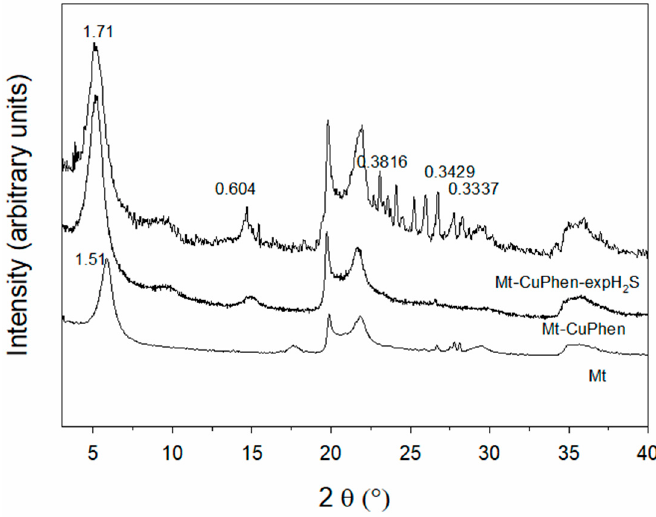
Figure 4. X-ray di ff raction patterns of Mt and Mt-CuPhen before and after exposure to H 2 S. Numbers on peaks indicate the d hkl values